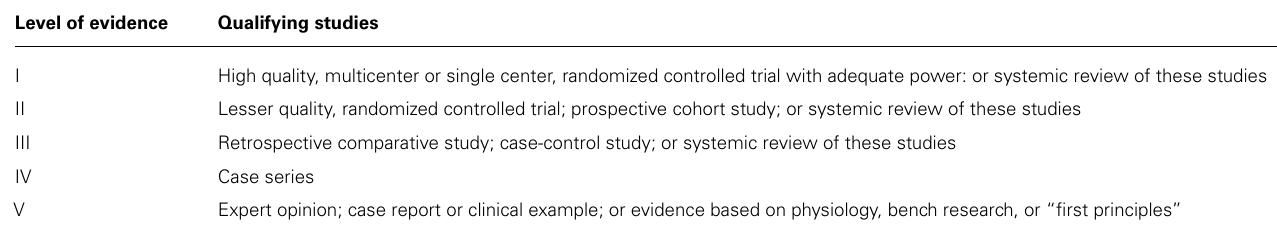
Table 1 | Evidence level provided by epidemiological studies of different